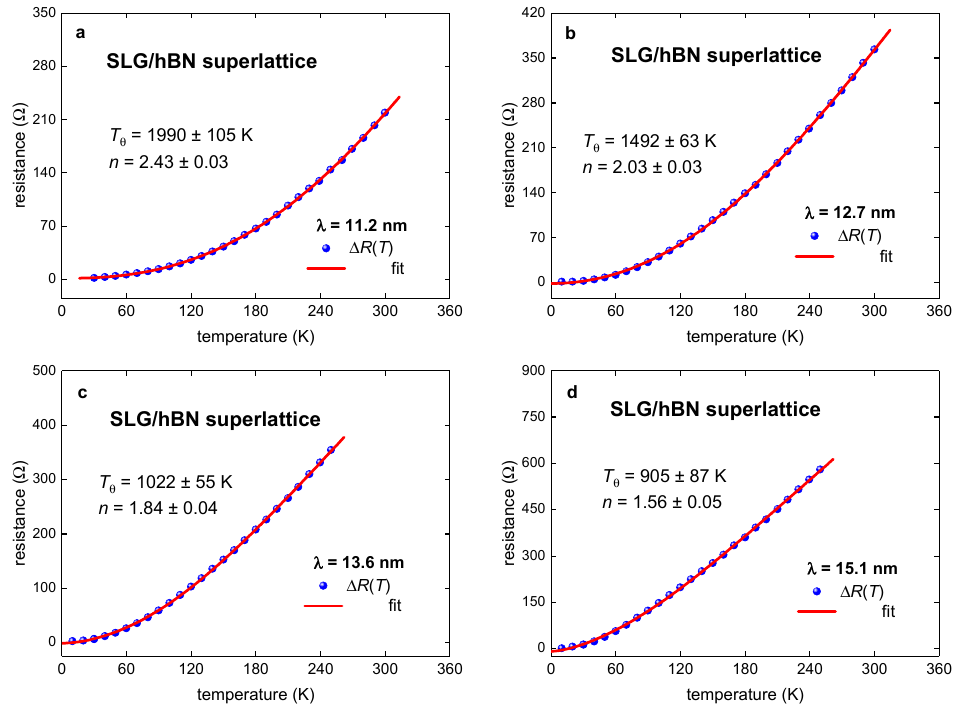
Figure 2. R ( T ) data for Moiré SLG/hBN superlattices (raw data reported by Wallbank et al. [10]) and fits to Equation (8) for ( a ) λ = 11.2 nm, ( b ) λ = 12.7 nm, ( c ) λ = 13.6 nm, and ( d ) λ = 15.1 nm. Red lines are the fitting curves; 95% confidence bands are shown by a pink shaded area. Goodness of fit for all plots is better than R = 0.9997.